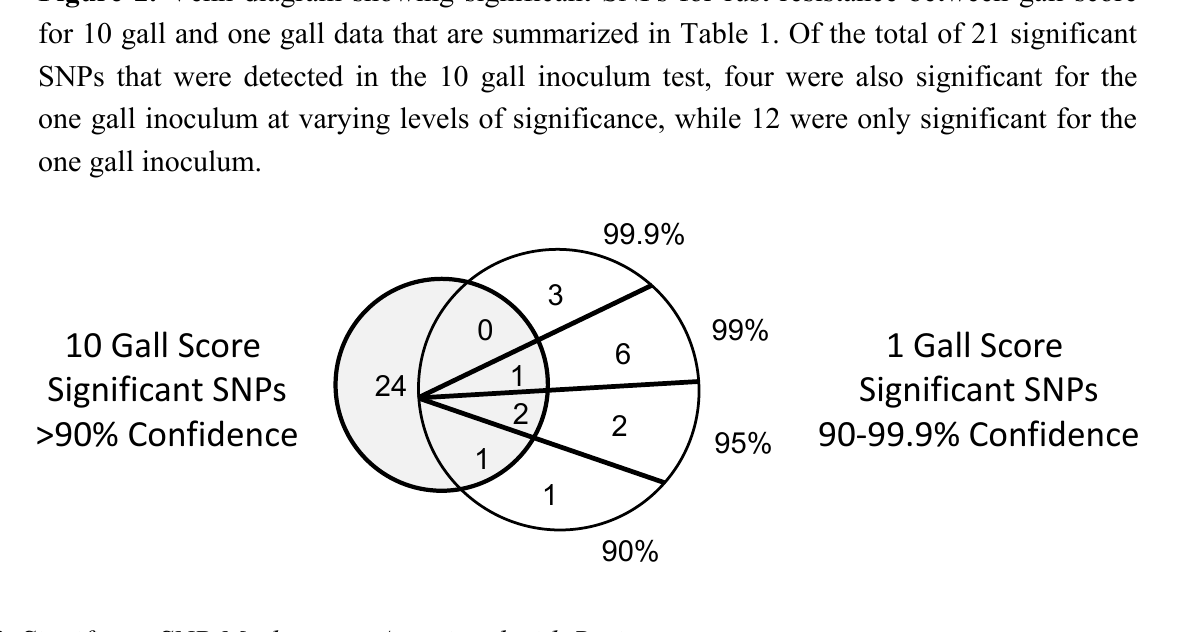
Figure 2. Venn diagram showing significant SNPs for rust resistance between gall score for 10 gall and one gall data that are summarized in Table 1. Of the total of 21